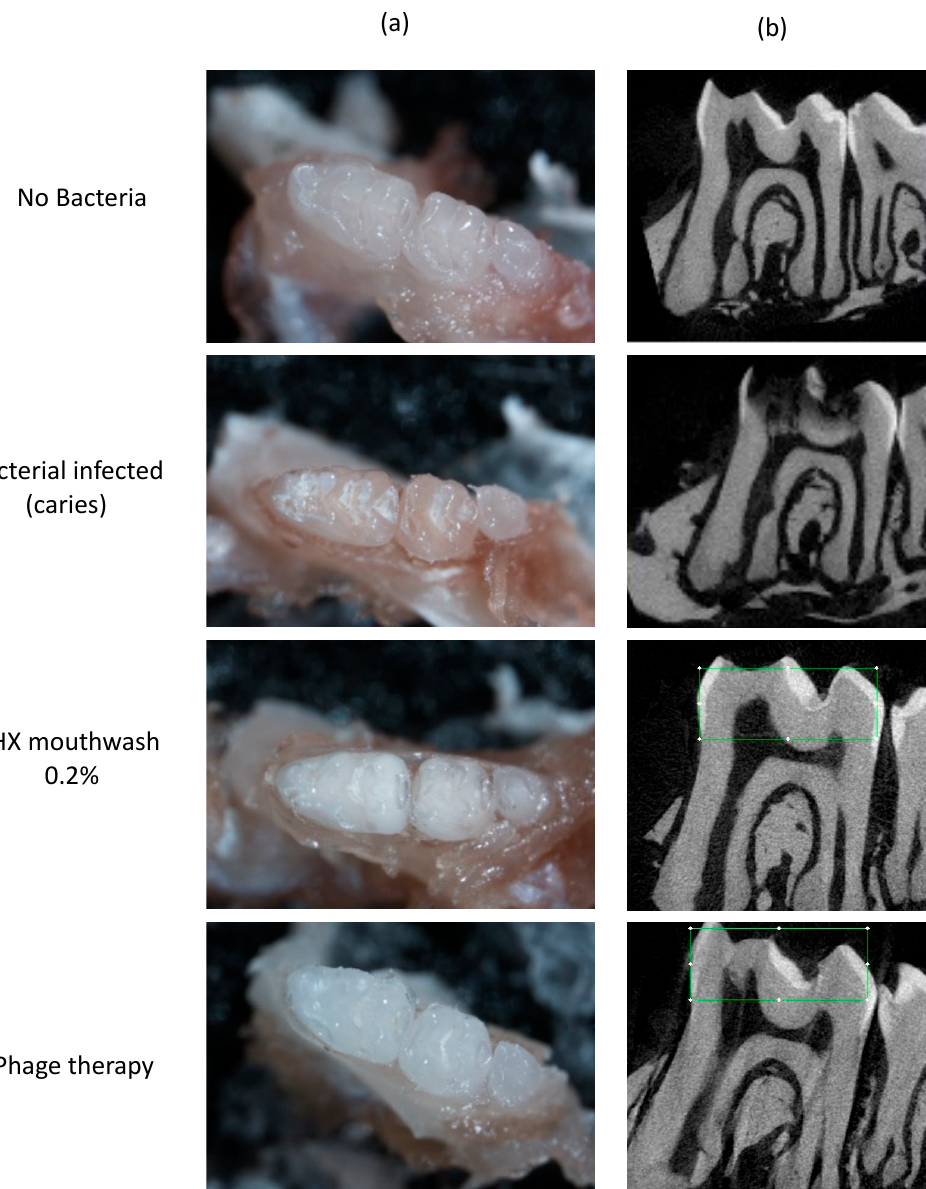
Figure 7. Clinical and radiographic evaluation demonstrate carious lesion development by S. mutans UA159 bacterial infection and high-sucrose diet. ( a ) Hemi-mandibles photographed using stereomicroscope. Representative clinical photographs depict extensive carious lesions in the group with S. mutans UA159 bacterial infection + high-sucrose diet; no carious lesions were found in the control (no bacteria) and CHX- and phage-treated groups. ( b ) Hemi-mandibles were segmented and reconstructed to acquire 2D images by µ